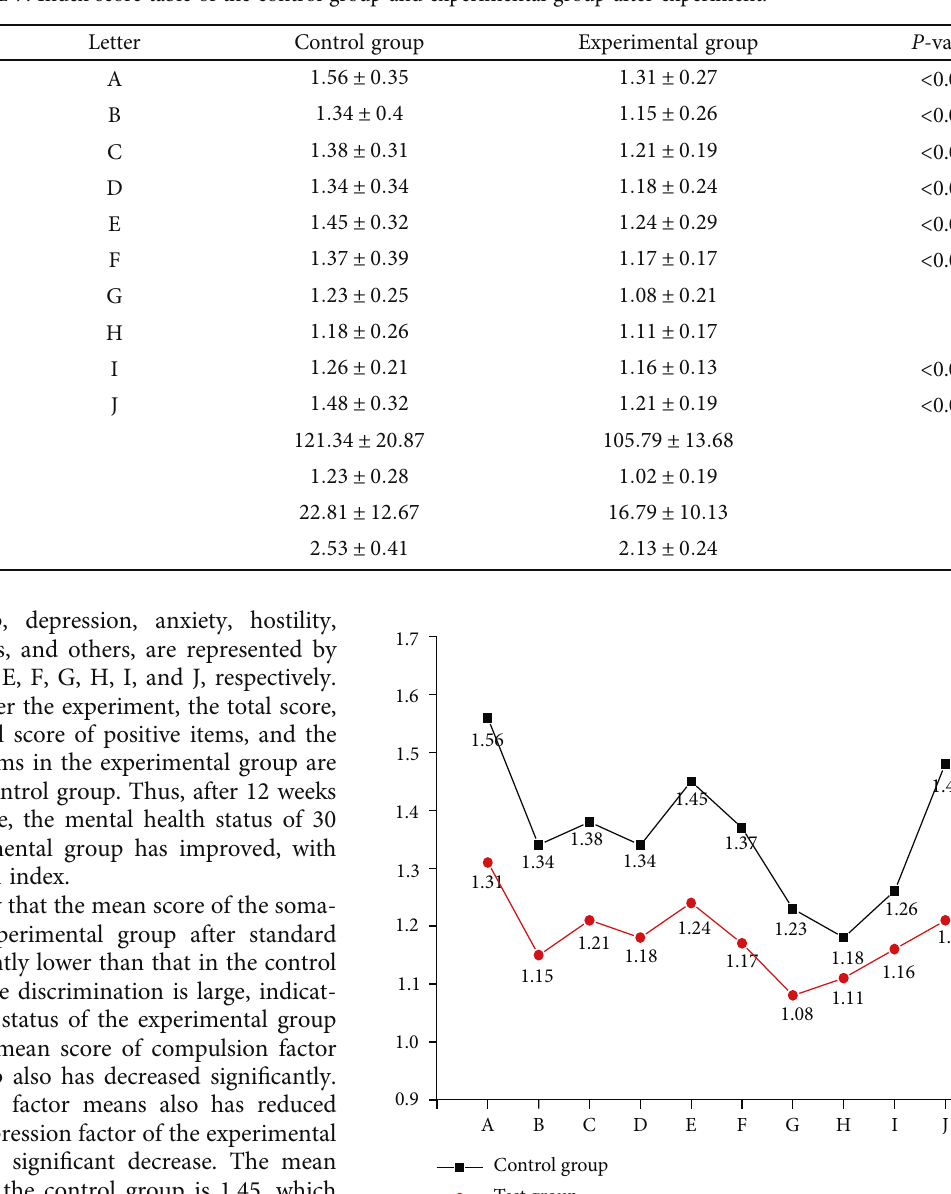
Table 7: Index score table of the control group and experimental group after experiment.